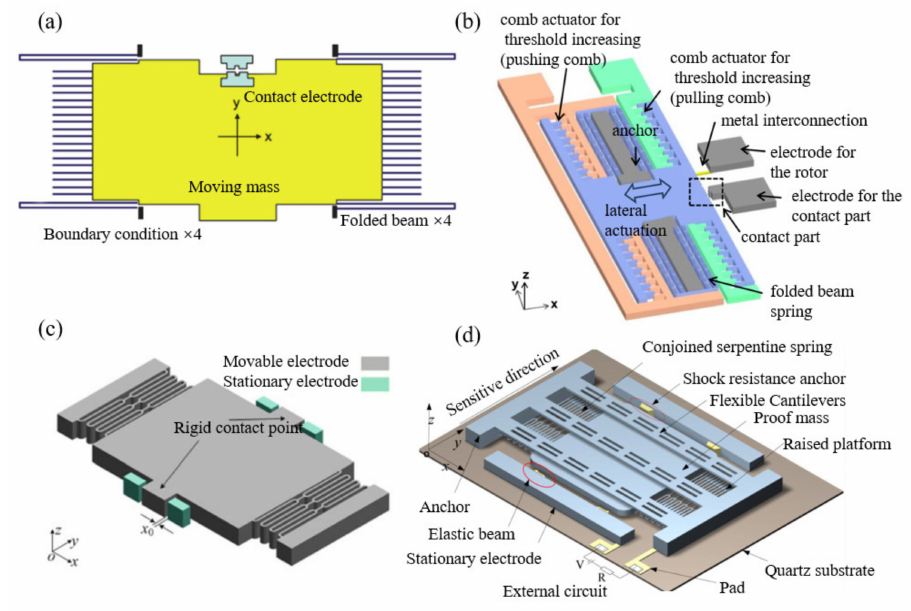
Figure 2. Some uniaxial inertial switches: ( a ) [40], ( b ) [12], ( c ) [41], ( d )